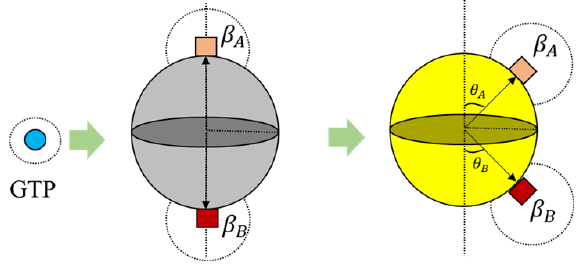
Figure 6. Bond displacement during activation of dimers as per Rule 3b for ring